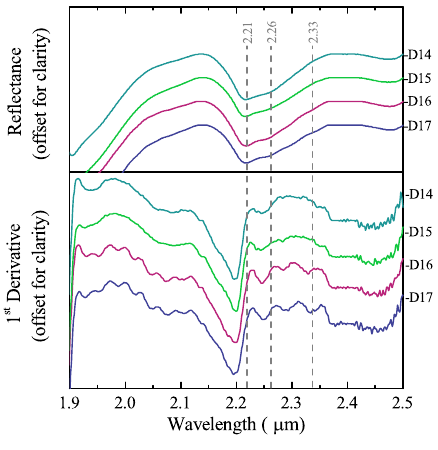
Figure 5. Bidirectional reflectance spectra of diatomite ore samples with variable content of CaCO 3 after continuum removal ( top ) and 1st derivative ( bottom ): D14 = 6.29 wt %, D15 = 10.9 wt %, D16 = 16.4 wt %, D17 = 24.4 wt %.